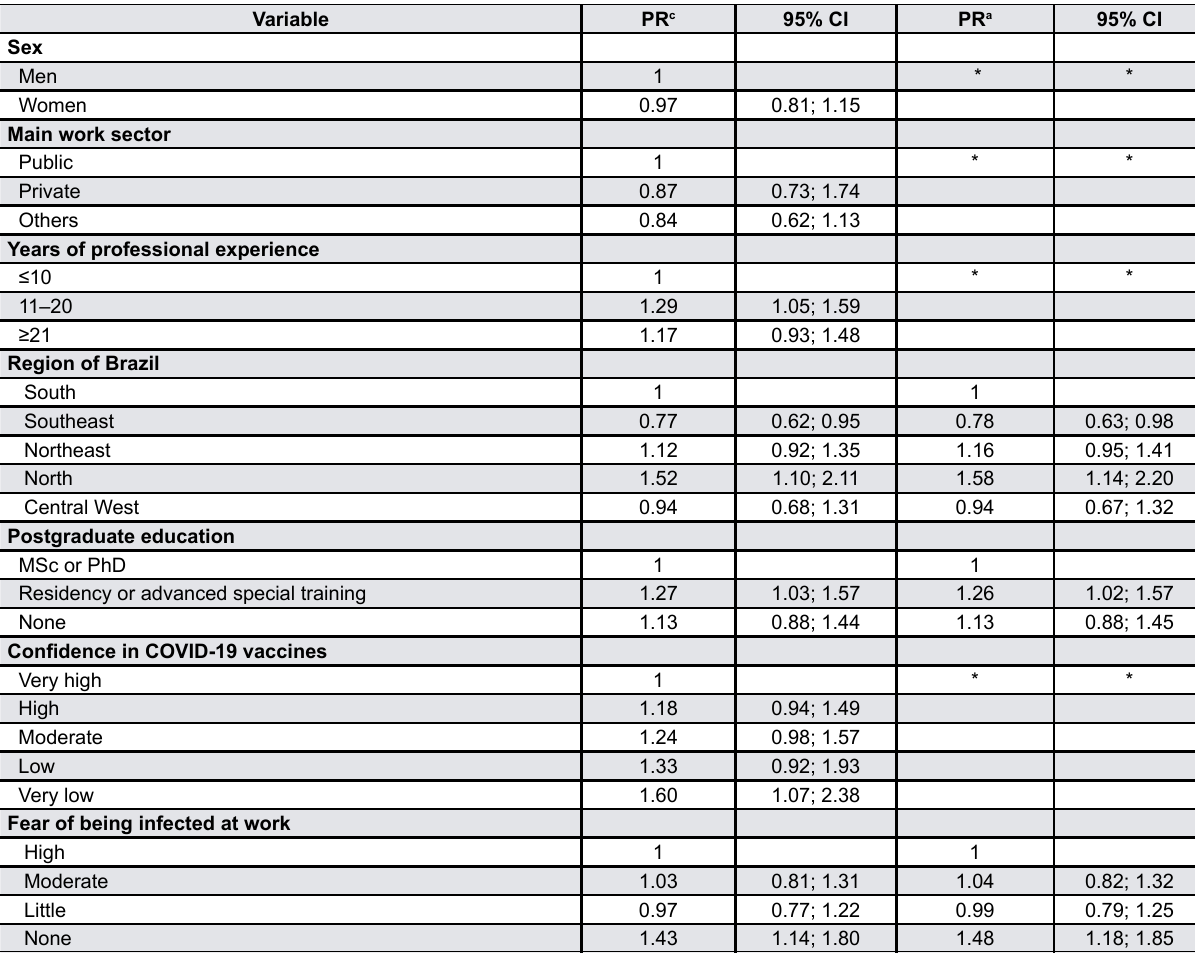
Table 2- Crude (c) and adjusted (a) prevalence ratios (PR) for the association between professional characteristics and COVID-19 infection. Multivariate Poisson regression analysis